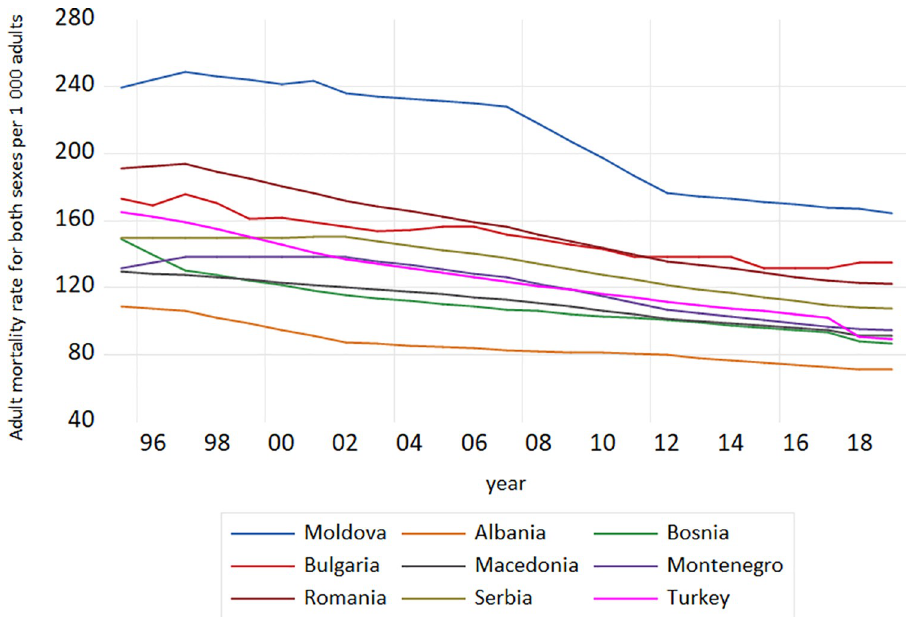
Fig 3. Adult mortality rate for both sexes in the European middle income countries, 1995–2019. Source: Author’s design based on World Bank and UN data.